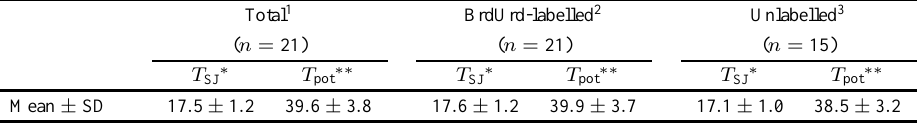
(cid:3) T SJ , T S calculated according to Johansson et al. [8]. (cid:3)(cid:3) T pot = T SJ =LI J , LI J calculated according to Johansson et al. [10]. 1 The mean DNA content of the G 1 phase cells obtained from the total cell